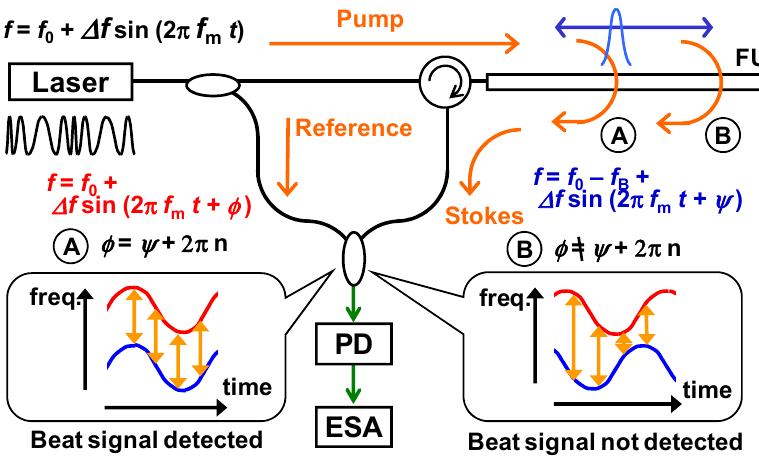
Figure 31. Basic BOCDR system [9].